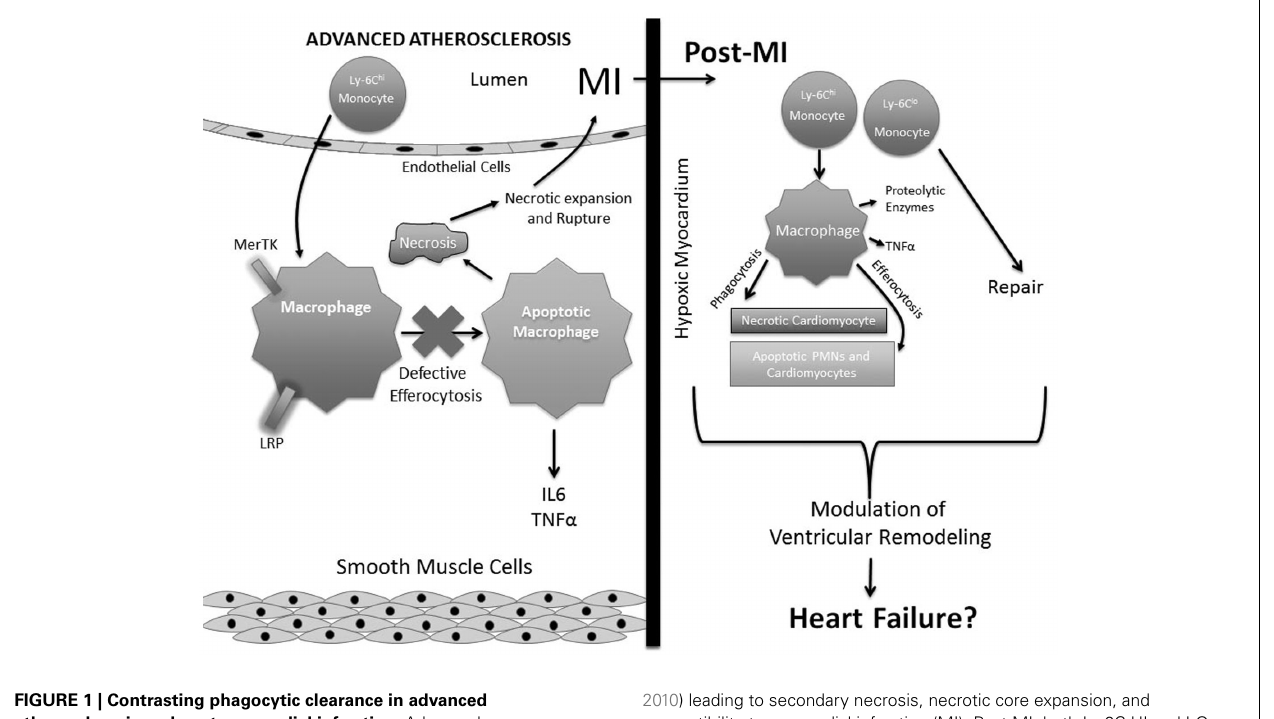
FIGURE 1 | Contrasting phagocytic clearance in advanced atherosclerosis and post myocardial infarction. Advanced atherosclerosis is characterized by recruitment of Ly-6C-HI monocytes that differentiate into macrophages. Macrophage apoptotic cell receptors, such as MerTK and LRP promote efferocytosis. However, in the inflammatory setting of mature atheromata, efferocytosis becomes defective (seeTabas,